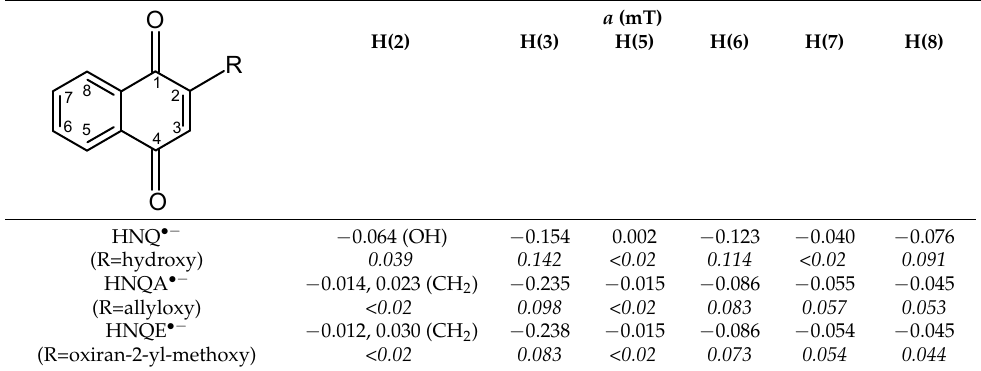
Table 3. The hyperfine coupling constants of 2-substituted naphthoquinone radical anions calculated at B3LYP/EPR-III/SMD (acetonitrile) level of theory in comparison with those elucidated from the simulations of experimental EPR spectra ( in italic ).